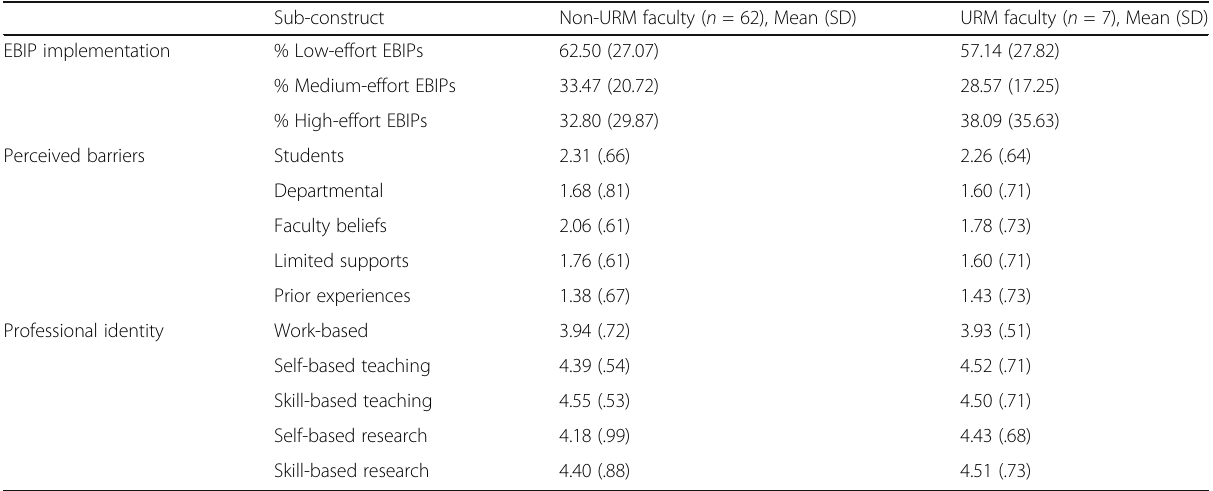
Table 11 Comparison of URM professional identity with perceived instructional barriers